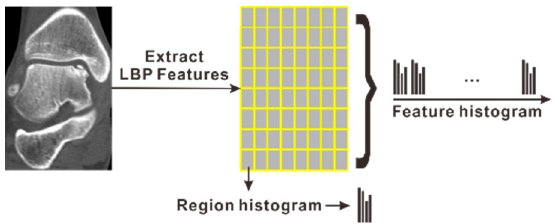
Figure 4. Input image region.